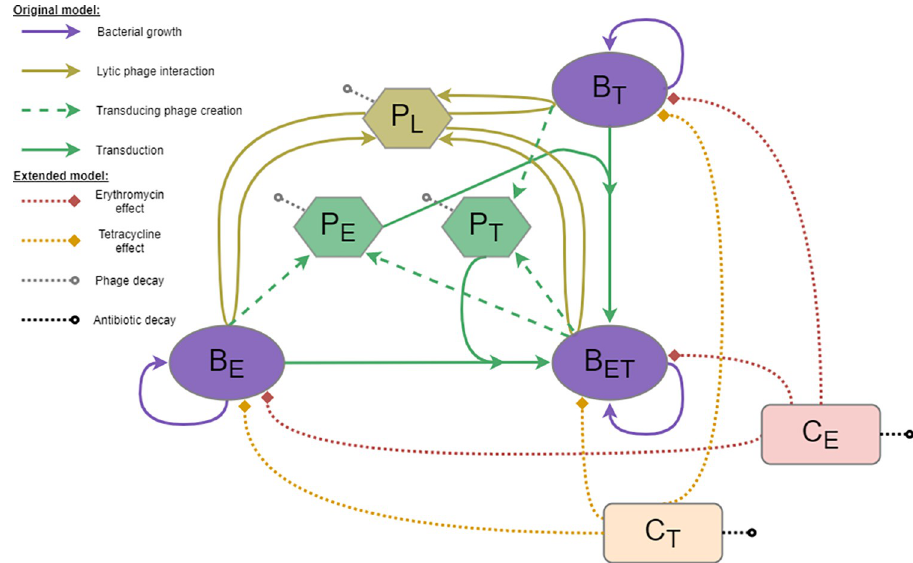
Fig 1. Mathematical model diagram. This model is an extension of our original model presented in [28], with the inclusion of antibiotic effects. Each bacteria strain (B E resistant to erythromycin, B T resistant to tetracycline, or B ET resistant to both) can replicate (purple). The lytic phage (P L ) multiply by infecting a bacterium and bursting it to release new phage (gold). This process can create transducing phage (P E or P T ) carrying a resistance gene ( ermB or tetK respectively) taken from the infected bacterium (dashed, green). These transducing phage can then generate new double-resistant progeny (B ET ) by infecting the bacteria strain carrying the other resistance gene (solid, green). The antibiotics, erythromycin (C E ) and tetracycline (C T ), decrease the growth rate of each bacteria strain to varying extents, depending on their concentration and the resistance level of the strain (dotted, red and orange). Phage and antibiotics can decay at a fixed rate (dotted, grey and